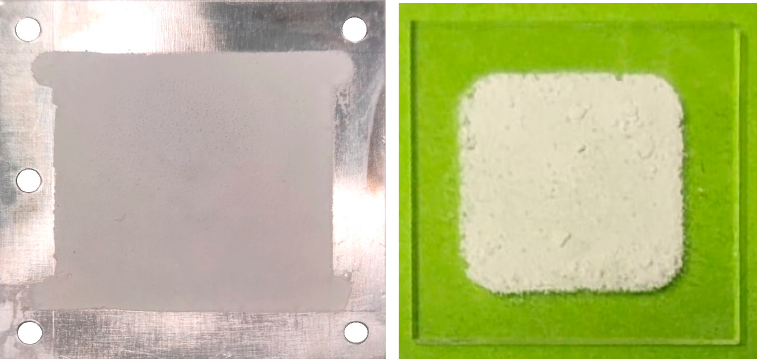
Figure 20. Two converters, 16 µm nominal layer thickness, produced by means of the chemical deposition technique. Left: on a 5 × 5 cm 2 aluminum substrate, using a larger mini-well. Right: on a 2 × 2 cm 2 glass substrate using a smaller mini-well. The two pictures are not to scale.